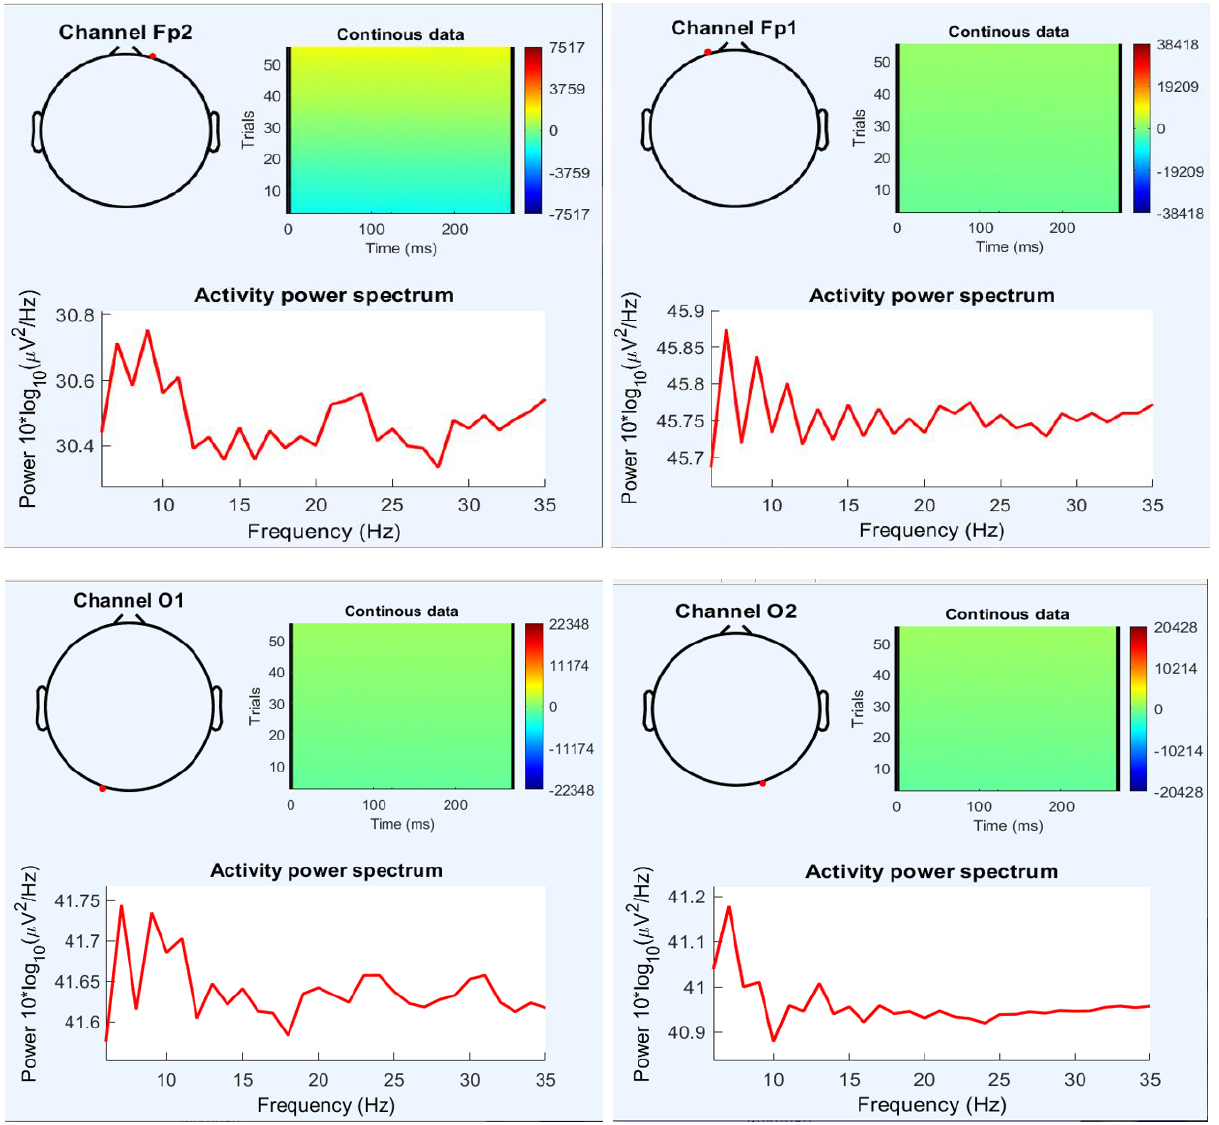
Fig. 12. Frequency and PSD for Fp1, Fp2, O1, and O2